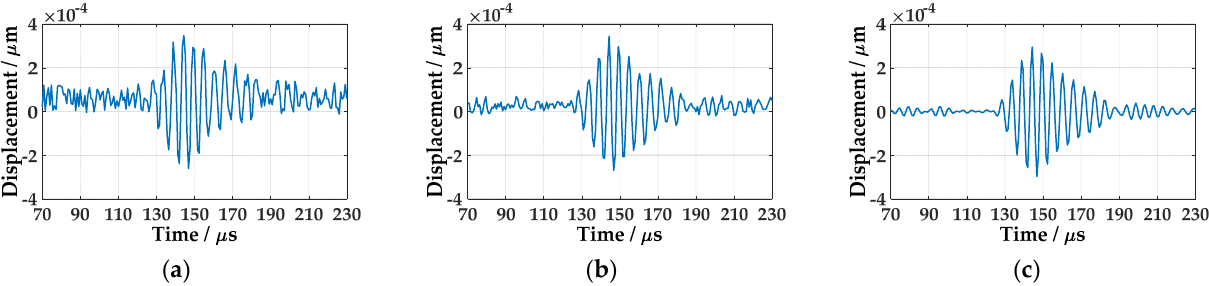
Figure 4. The wave at 40 mm in aluminum plate: ( a ) Single acquisition signal; ( b ) Average of 32 acquisitions; ( c ) After filtering.